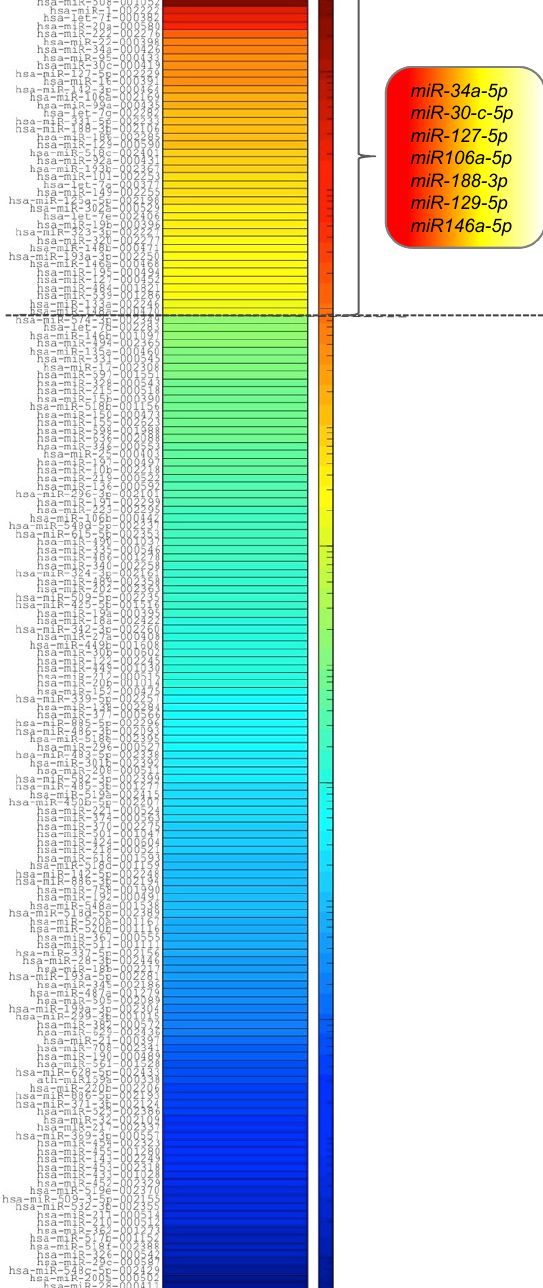
Figure 2. Heat map diagram of the miRNA profile of MM1.S-EVs based on miRNA expression (2ˆ ∆ Ct vs snoU6). The dotted line separates the miRNAs with higher abundance (Ct < 31, 2ˆ ∆ Ct ≥ 0.002) from the less abundant species (Ct > 31, 2ˆ ∆ Ct <